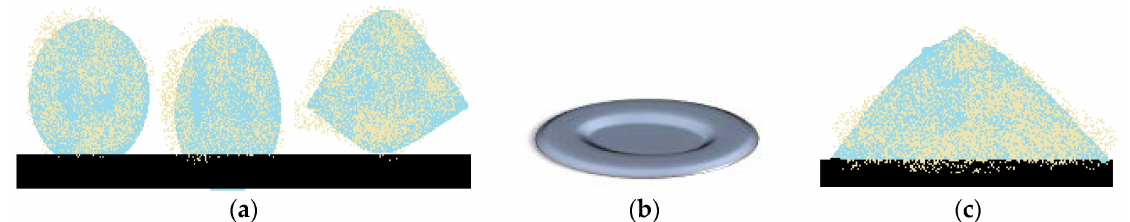
Figure 10. Shape changes in freezing liquid marbles. ( a ) initial shape, “dome” and “flying saucer” shape; ( b ) central “crater”; ( c ) “pointy